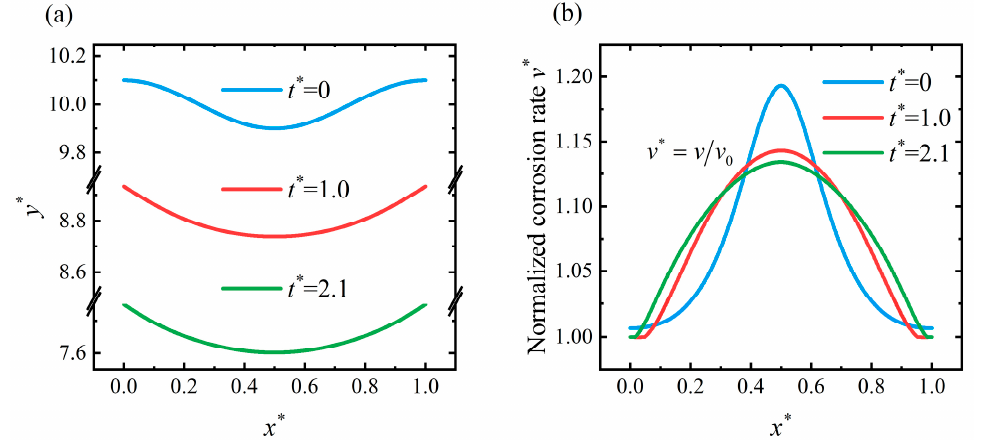
Figure 16. ( a ) Surface morphology evolution process and ( b ) corrosion rate distribution when A ∗ = 0.1 and σ A = 10 MPa.